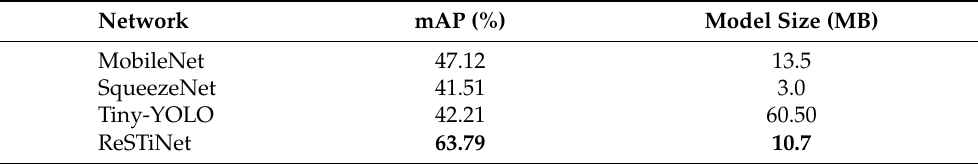
Table 5. ReSTiNet vs. other lightweight models.